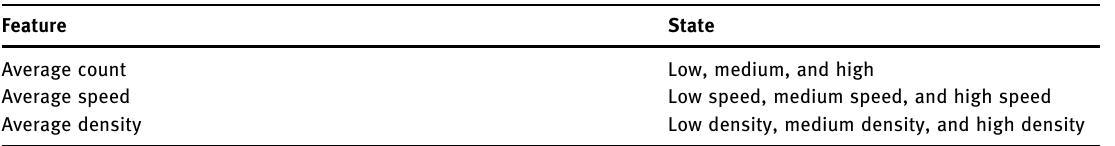
Table 4: Tra ffi c features and their states